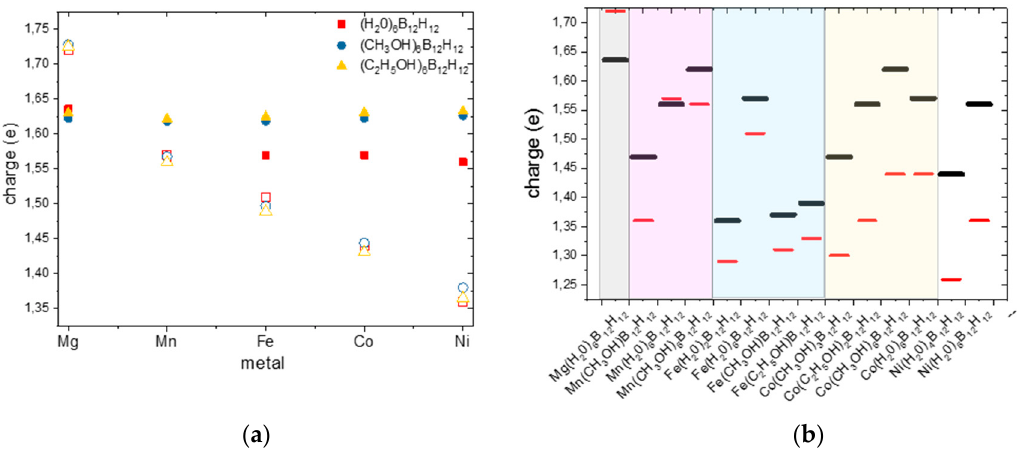
Figure 13. ( a ) Bader charges on metals (empty symbol) and on the octahedral complex (full symbol) cation with water, ethanol and methanol ligands as a function of valence electrons number. ( b ) Bader charges on selected complexes as a function of valence electrons number (black line for the entire complex, red line for the metal).